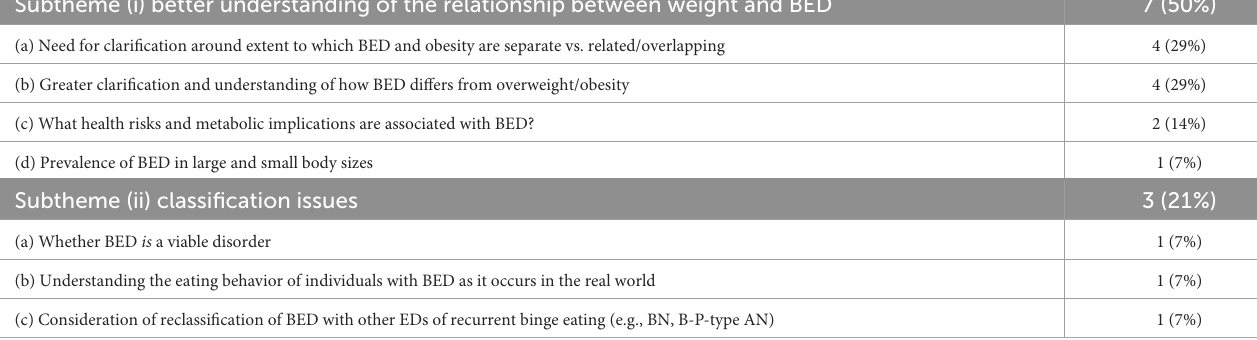
TABLE 13 Participant responses related to theme 8, “research gaps and future directives”. Subtheme (i) better understanding of the relationship between weight and